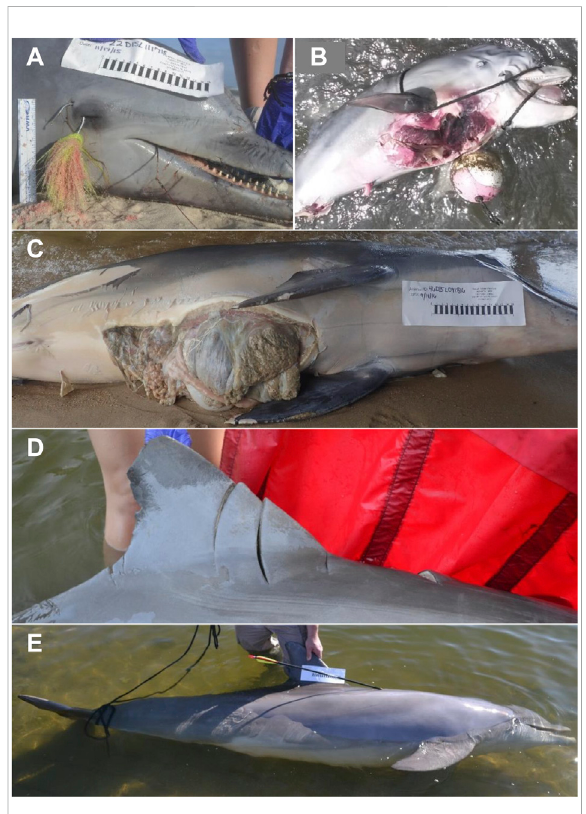
FIGURE 6 Examples of HI-positive dolphin stranding cases in Alabama, including fi shery interaction [hook and line, (A) ; crab pot entanglement, (B) ; mutilation (ventrum sliced; (C) ; boat collision (acute trauma; (D) ; purposeful harm (shot with arrow; (E)